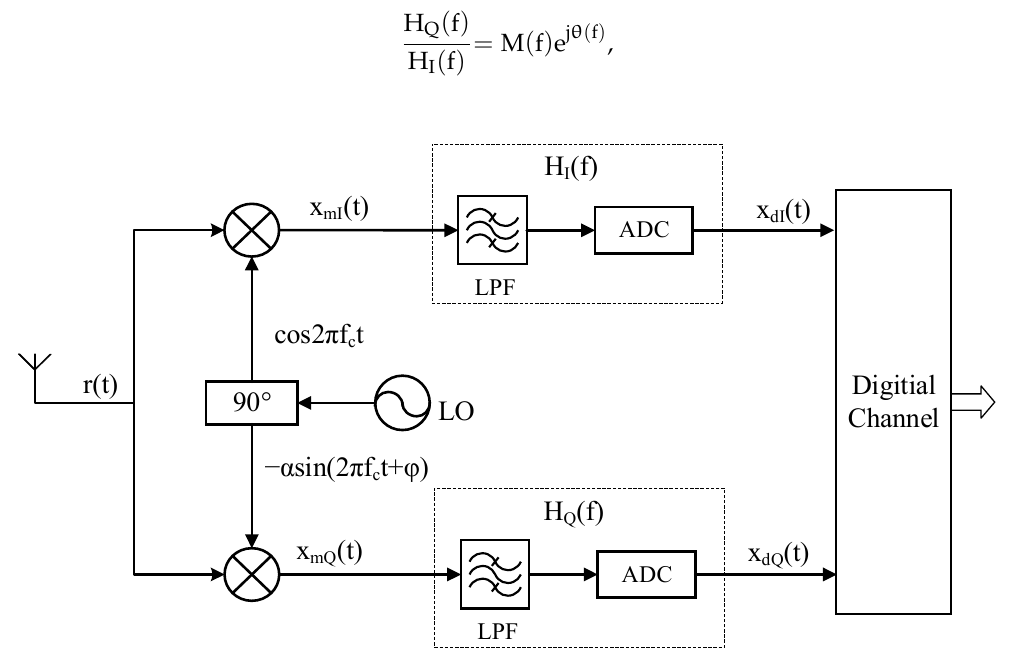
Figure 3. Typical structure of a zero-IF